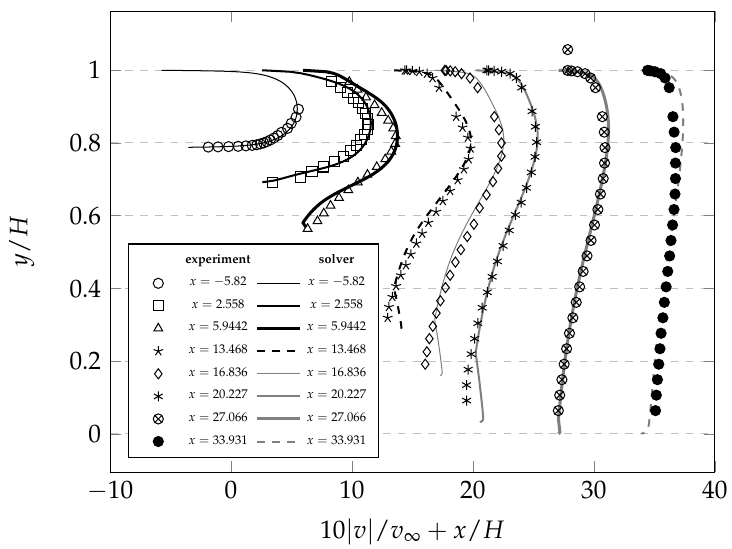
/ v ∞ + x / H v / v ∞ + x / H v | | | |